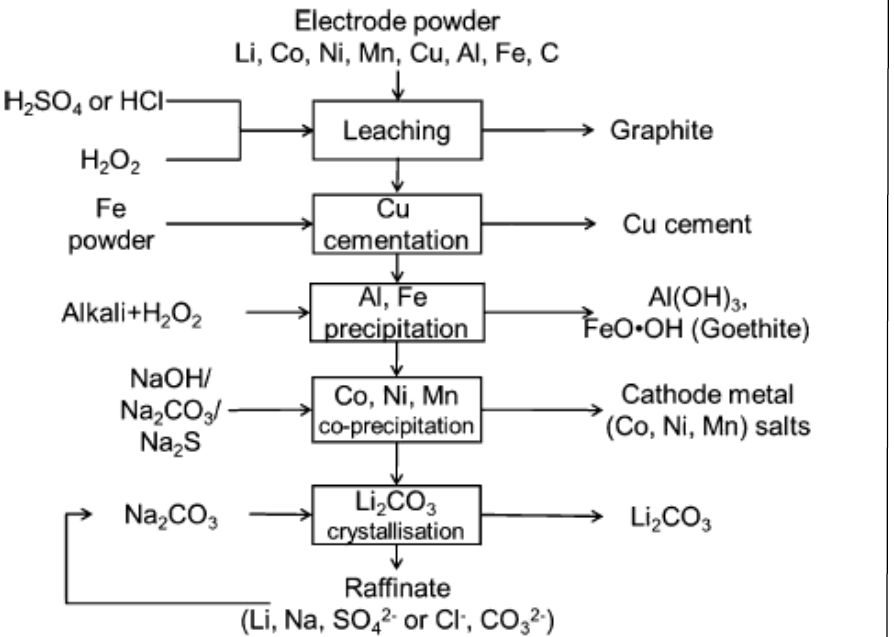
Figure 7 – Developed hydrometallurgical recycling process for Co (Wang &